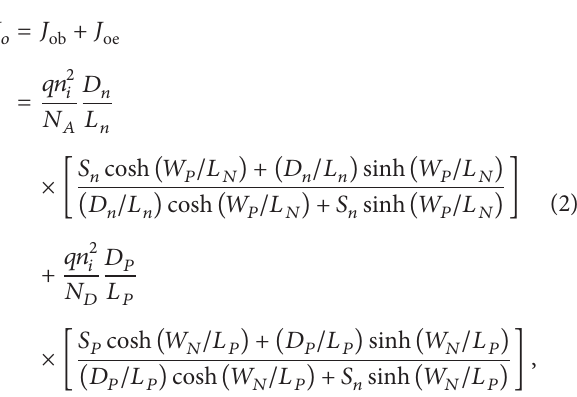
From (2), a better surface passivation and henceforth a